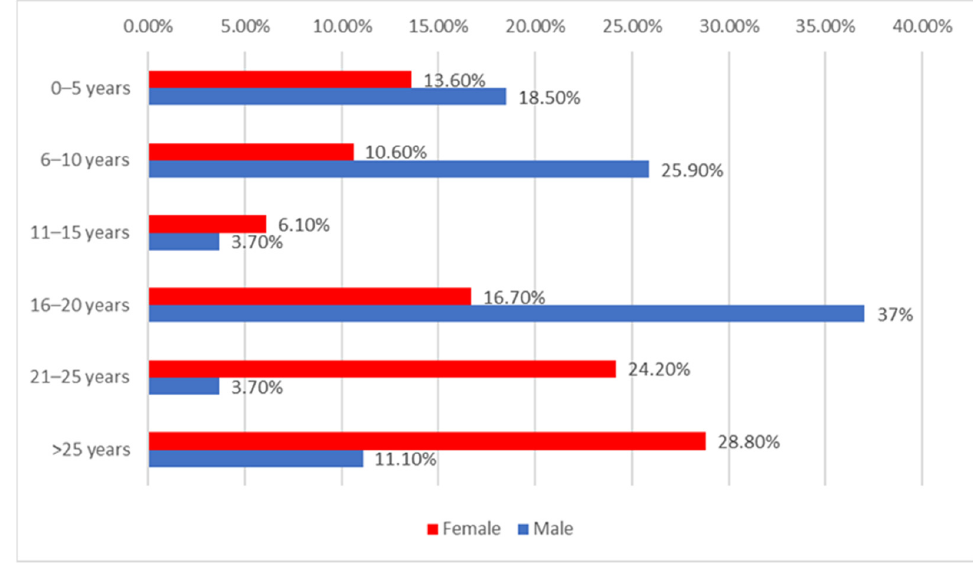
Figure 2. Distribution of the university teachers according to employment duration and gender.